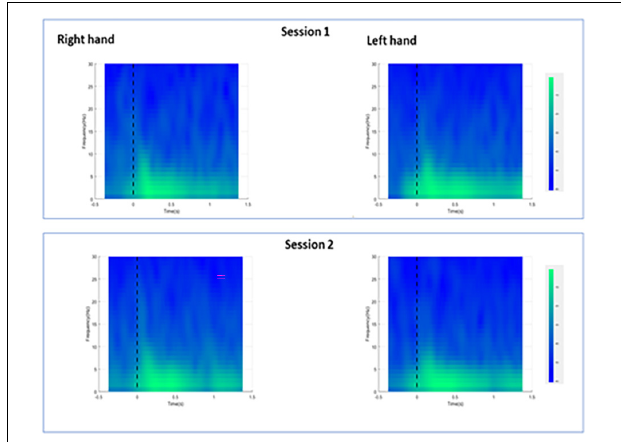
FIGURE 3 | Averaged spectra for all participants during right and left hand pin-prick stimulation at the Cz